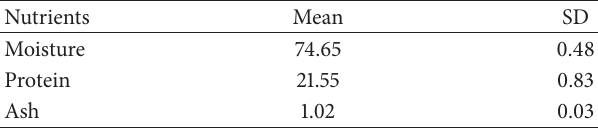
Table 2: Chemical composition of the LD muscle